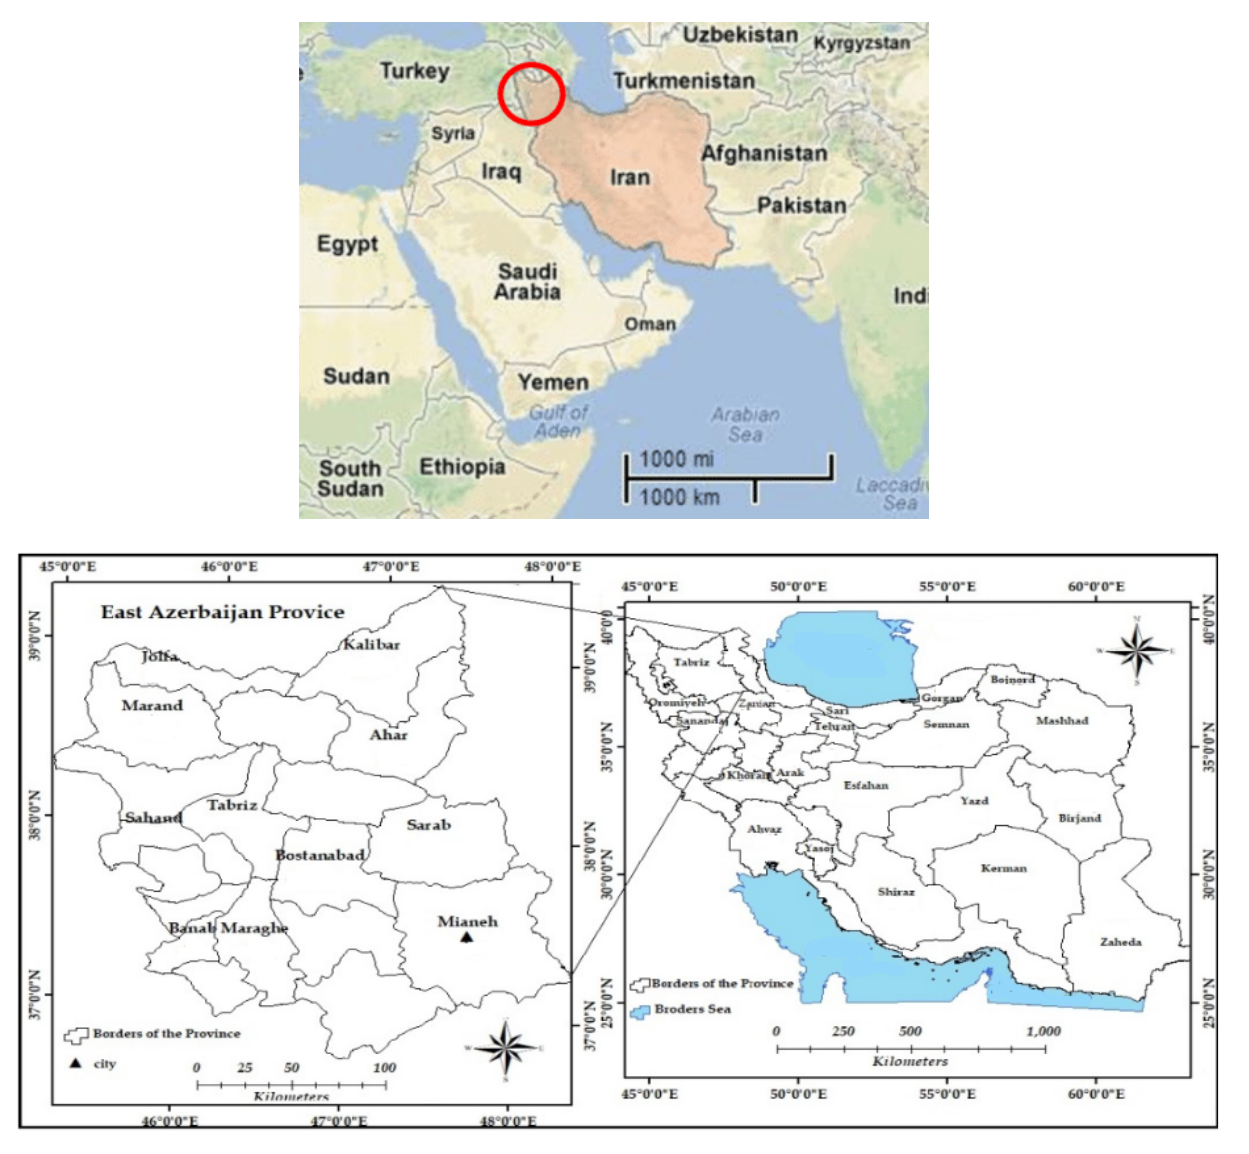
Figure 1. Location of study area in the West North of Iran. Table 1. Saffron crop requirements (Institute Research Water and Soil of Iran